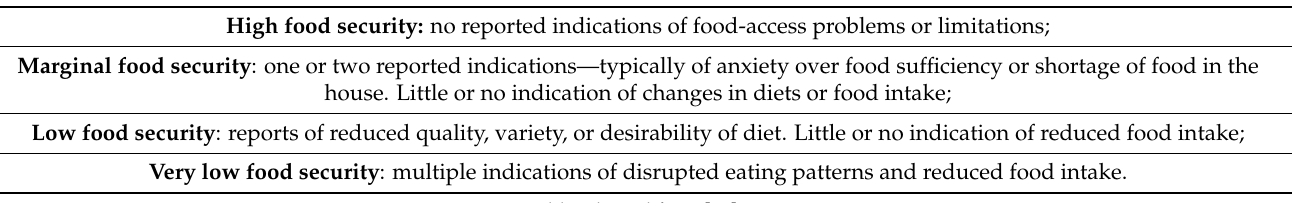
Table adapted from